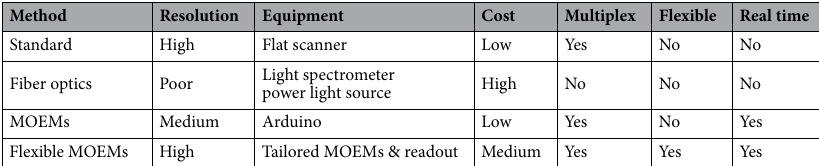
Table 2. Comparison of the main features of current active dosimeters based on gafchromic